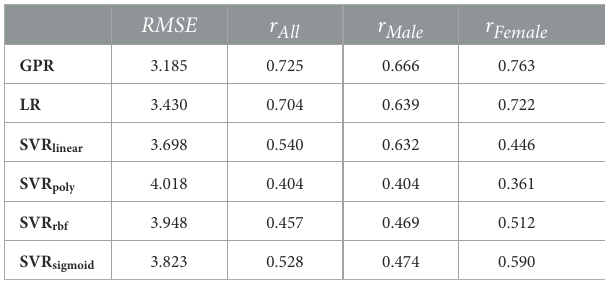
TABLE 5 Criterion validity of the anxiety assessment model for males and females.